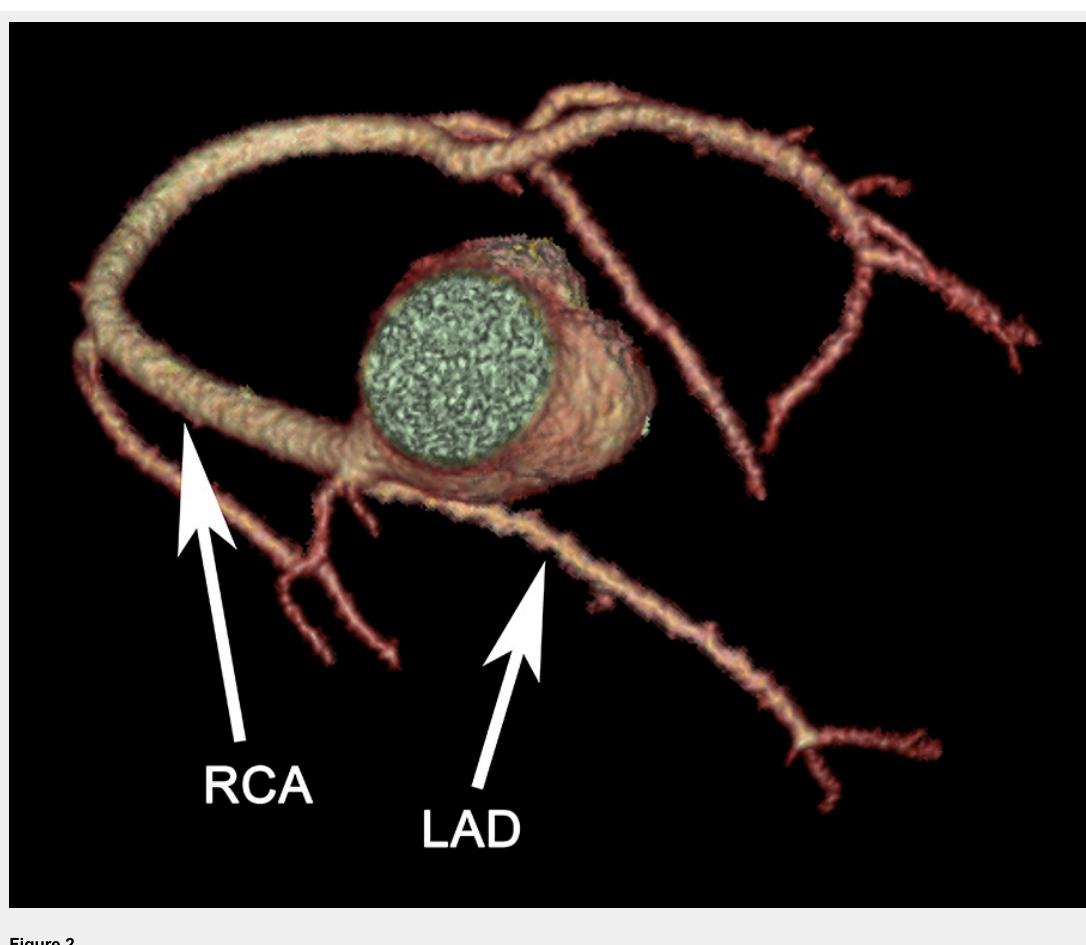
A patient with suspected coronary artery anomaly in echocardiography has a “single right” coronary artery, as depicted by CCTA. CCTA = coronary computed tomography angiography; LAD = left anterior descending artery; RCA = right coronary